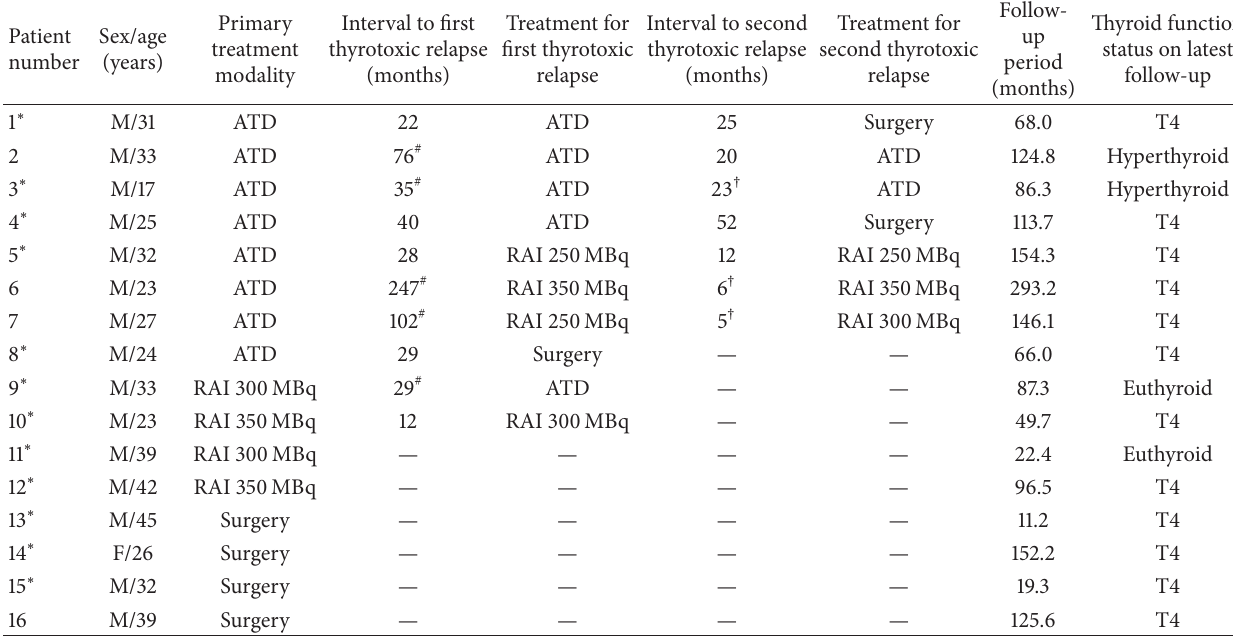
Table 3: A summary of the clinical course of the 16 patients with thyrotoxic periodic paralysis secondary to Graves’ disease (TPP/GD). Patient Sex/age number